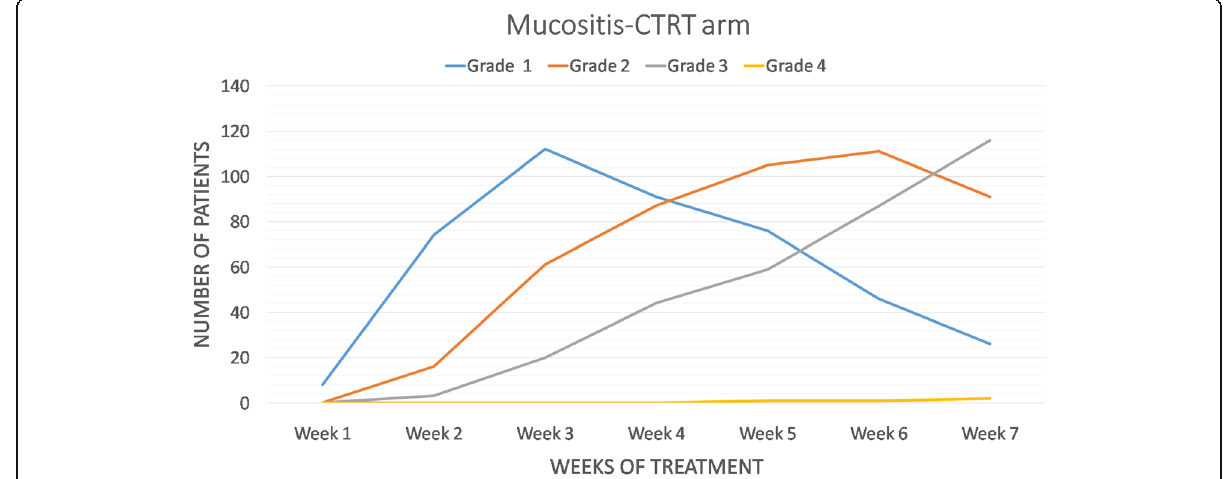
Fig. 3 Temporal evolution of the pattern of mucositis per week in cisplatin arm